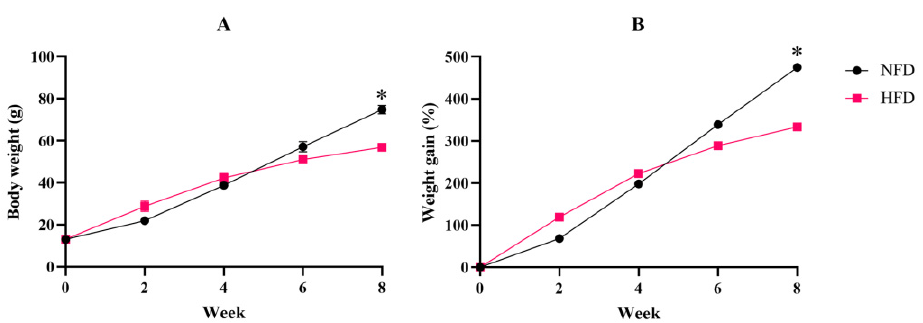
Figure 1. Experiment I. ( A ) Body weight. ( B ) Weight gain. “*” indicates a significant difference between groups ( p < 0.05, Student’s t -test, n = 3). Weight gain = final body weight/initial body weight.